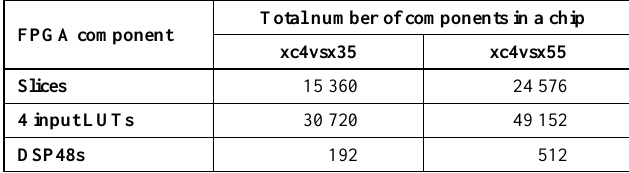
N UMBER OF C OMPONENTS IN S ELECTED FPGA M